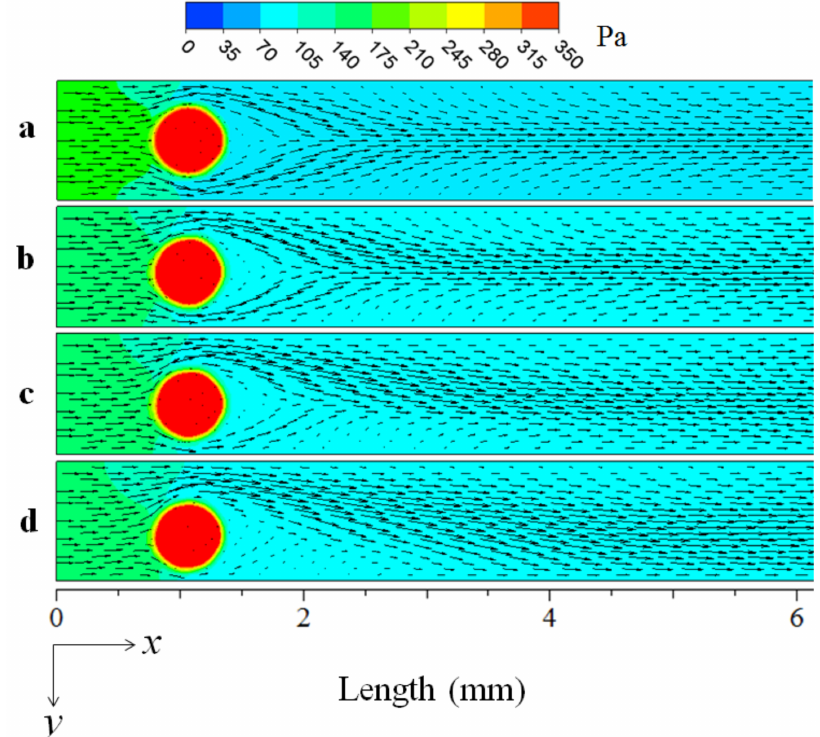
Figure 6. Flow field (velocity plot) and pressure in the cross sectional plane of the flow channel having various initial water locations at the time instant of 1 ms, with the plane distance of 0.3 mm to the MEA surface: ( a ) D = 0, the conventional case; ( b ) D = 0.05 mm, Case 1; ( c ) D = 0.1 mm, Case 2; ( d ) D = 0.15 mm, Case 3. D is the distance from the water spreading center to the MEA central line on the MEA